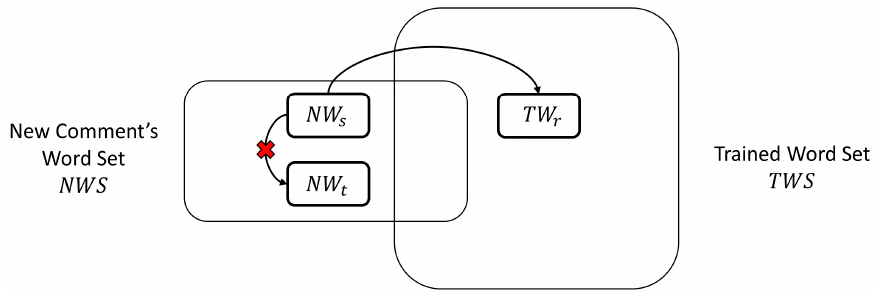
Figure 3. Similar Word Replacement for Political Stance Classification.